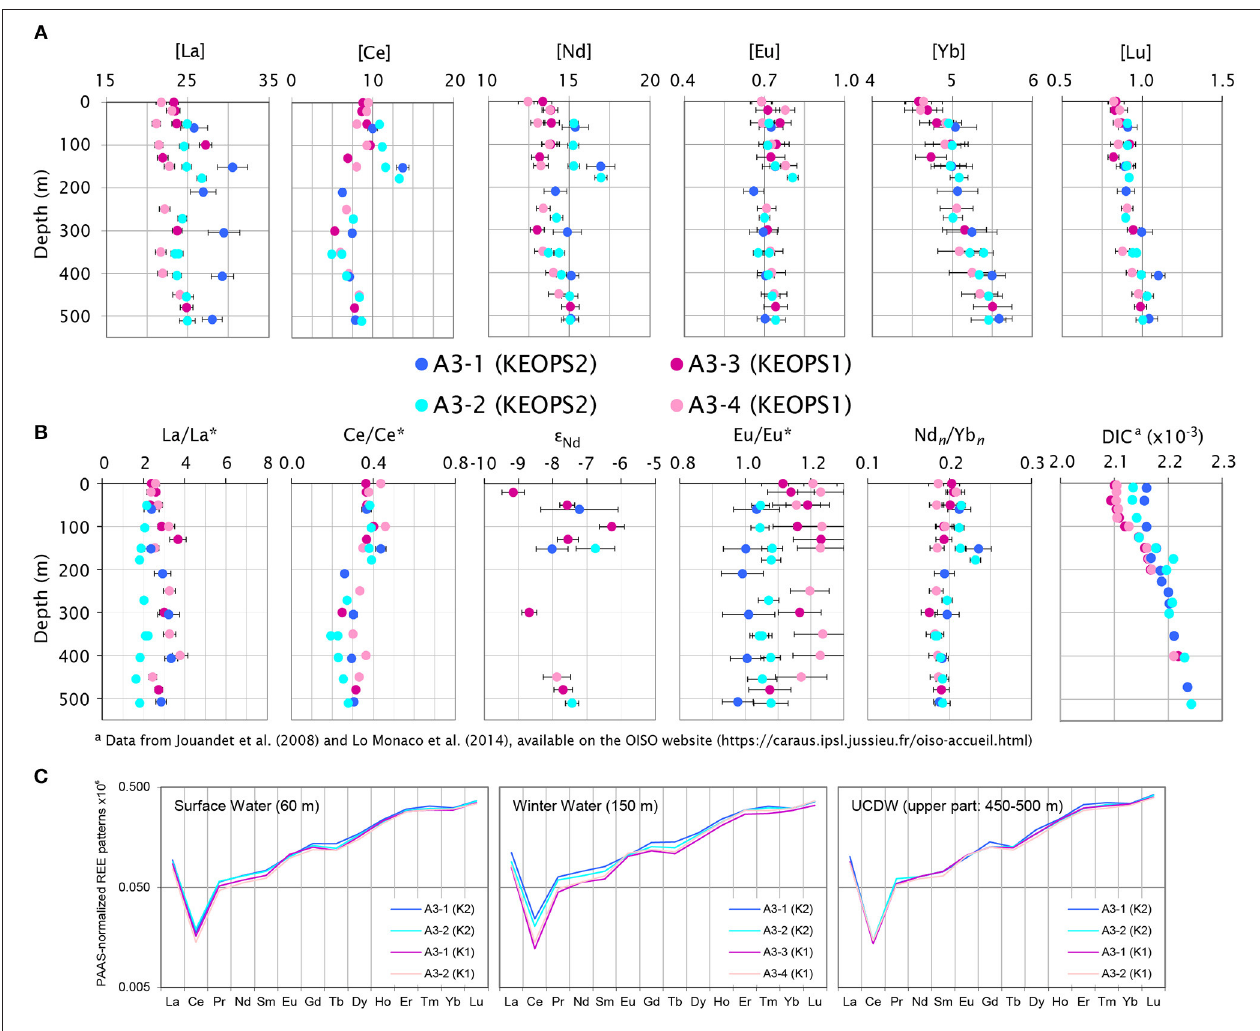
FIGURE 8 | Comparison of the dissolved REE distributions of station A3 for the four different visits: A3-1 and A3-2 refer to the two spring visits (KEOPS2) and A3-3 and A3-4 refer to the 2 summer visits (KEOPS1). (A) Concentration vertical profile of some of the REEs (in pmol kg-1), as in Figure 3 ; (B) Vertical profiles of some REE fractionations and of Nd n /Yb n , from the PAAS-normalized REE patterns shown in (C) . The associated Nd isotopic composition, expressed as ε Nd , and the concentrations of dissolved inorganic carbon (DIC, in µ mol kg − 1 ) are also shown. Error bars are defined as in Figures 3 , 5